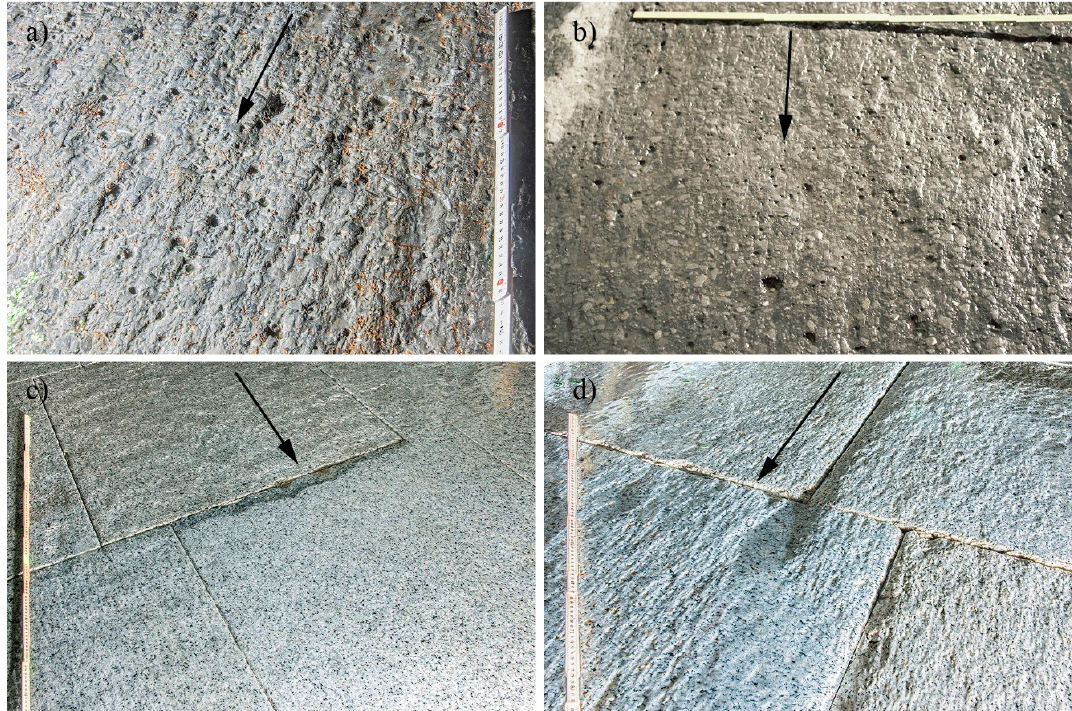
Figure 4. Close-up view of the abraded surface of the Pfaffensprung SBT: ( a ) high-strength concrete test field C1 after four operational years, ( b ) high-strength concrete test field C2 after two operational years, ( c ) granite test field G1 after four operational years showing abrasion concentration at upstream edges and ( d ) granite test field G1 after four operational years showing abrasion concentration along joints with downstream abrasion shadows.